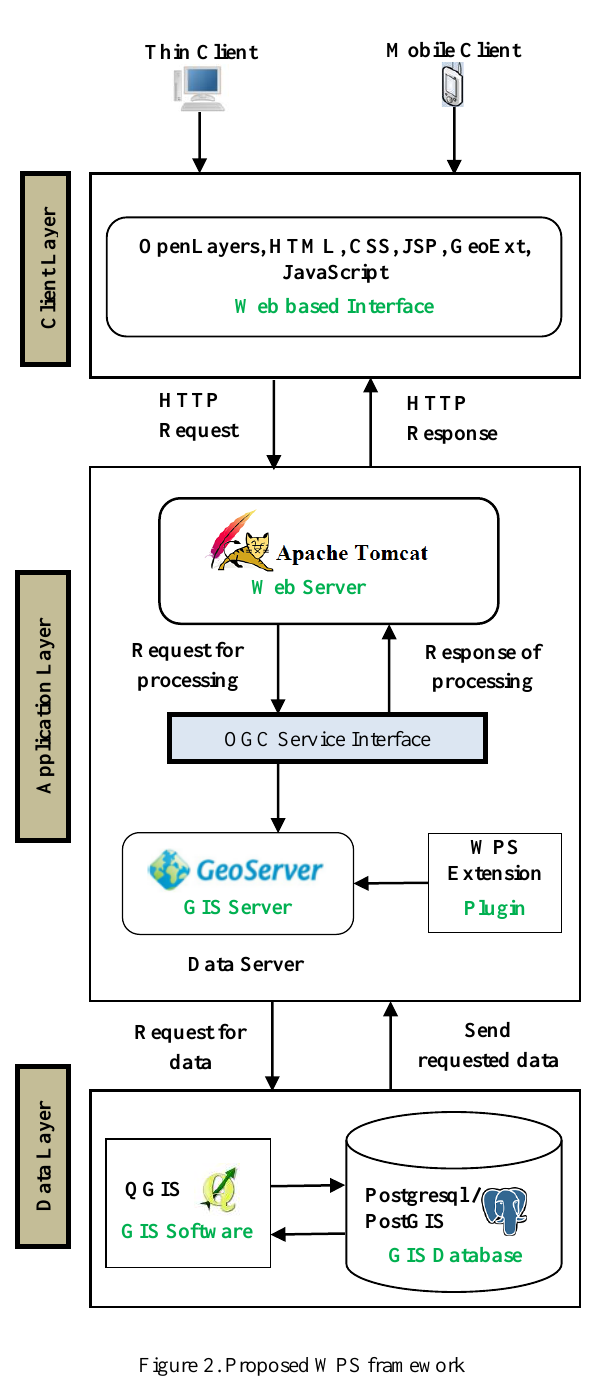
Figure 2. Proposed WPS